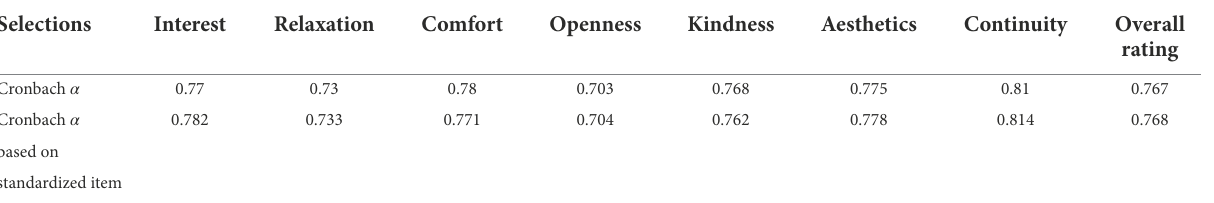
TABLE 7 Item reliability coefficients.